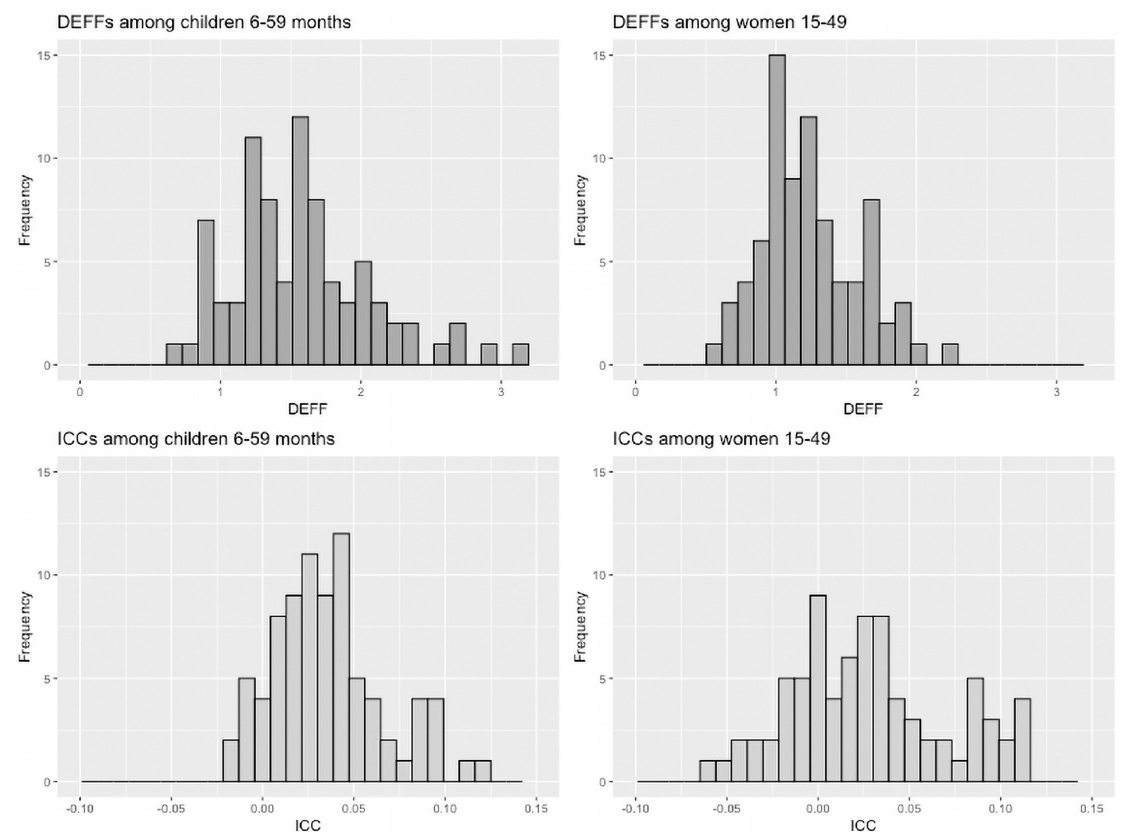
Fig 1. Distribution of anemia design effects and intracluster correlation coefficients for women and young children. DEFF: Design Effect; ICC: Intracluster correlation coefficient.